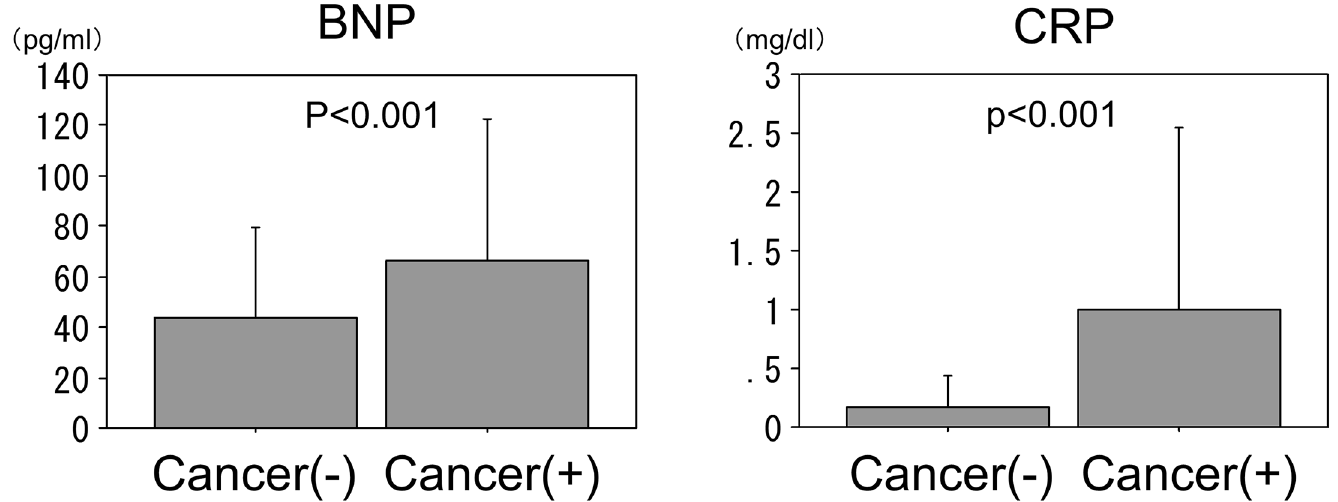
Fig 1. Plasmabrain natriuretic peptide (BNP) and serum C-reactiveprotein (CRP) levels in patients with and without cancer. Both the BNP and CRP levels were significantlyhigherin the patients with cancer than in those without.